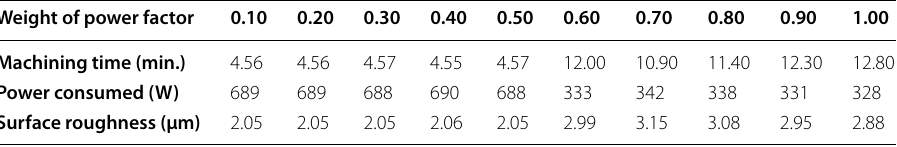
Table 7 Variation of PMS output results with different weights of delivery date Weight of delivery date 0.10 Machining time (min.) Power consumed (W) 690 Surface roughness